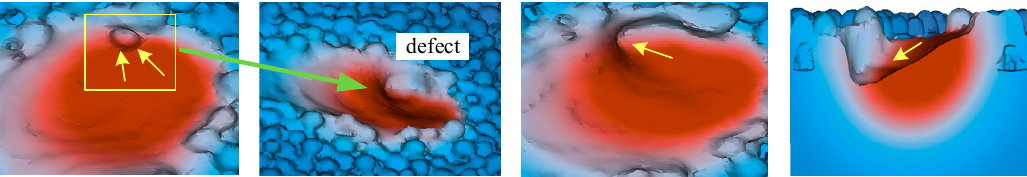
Figure 6. Schematic diagram of defects appearing at the edge of the melt channel with energy level 9 × 10 11 J/m 3 , P = 450 W, and V = 200 mm/s.